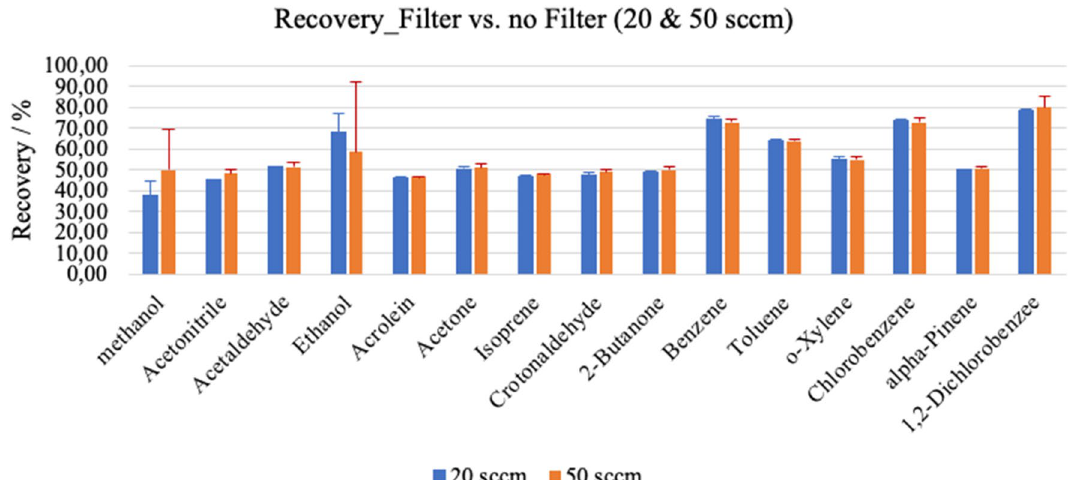
Figure 2. Recovery rates of VOCs concentrations with side-stream syringe filters at two different sampling flow rates. VOCs intensities obtained through measurements without filters represent 100%, VOCs intensities obtained through measurements with syringe filter are presented in % in relation to measurements without filter. VOCs concentration was approximately 100 ppbV. Blue bars represent measurements with a sampling flow rate of 20 sccm (i.e. mL/min), orange bars represent measurements with a sampling flow rate of 50